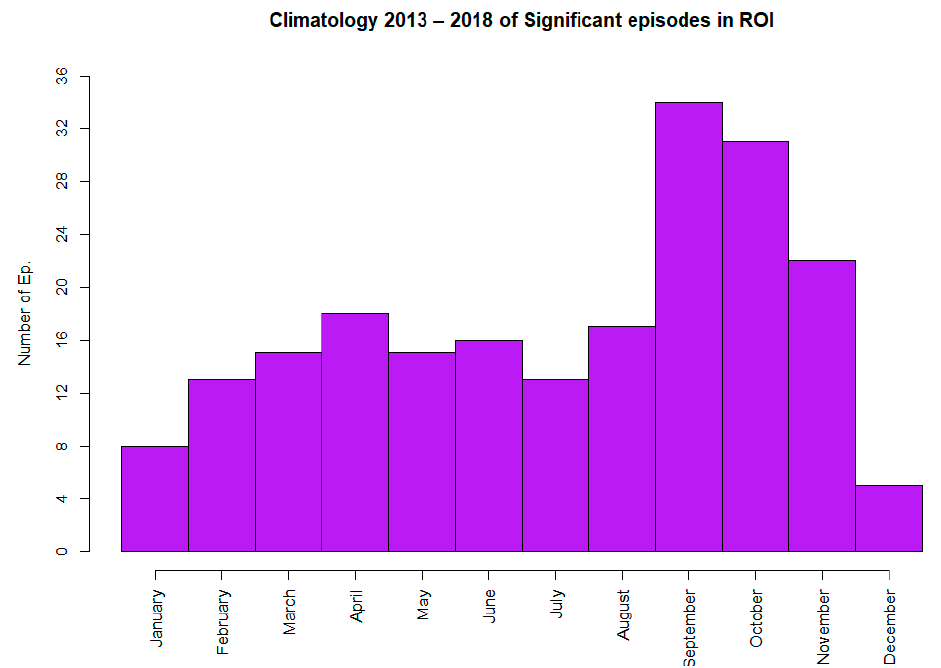
Figure 4. Monthly evolution of significant rainfall episodes from April 2013 to December 2018.